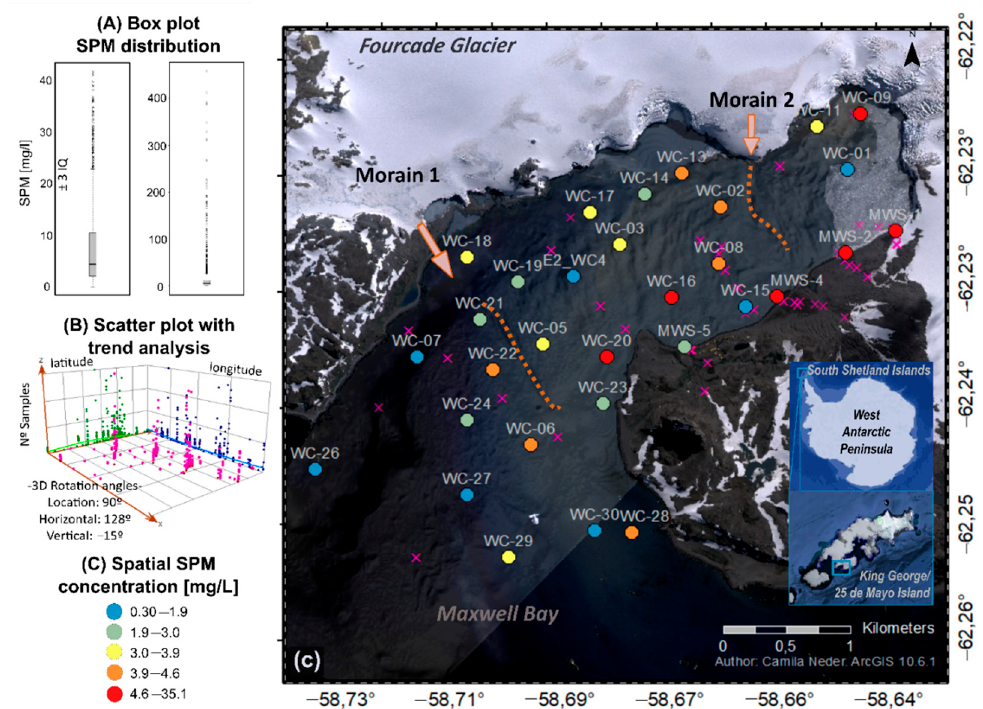
Figure 3. Suspended particulate matter (SPM) measured at least once during summers among two decades (1992–2012) in Potter Cove. ( A ) Data distribution by a boxplot. ( B ) Scatter plot with trends in sample densities variability. ( C ) One-day of SPM concentration sampling on 9 February 2010 in Potter Cove’s upper water column (WC stations) and its meltwater streams (MWS stations). Red and blue colors highlight extreme high and low values. Moraine from Wölfl et al. [51]. Base map: Digital Globe (2014).